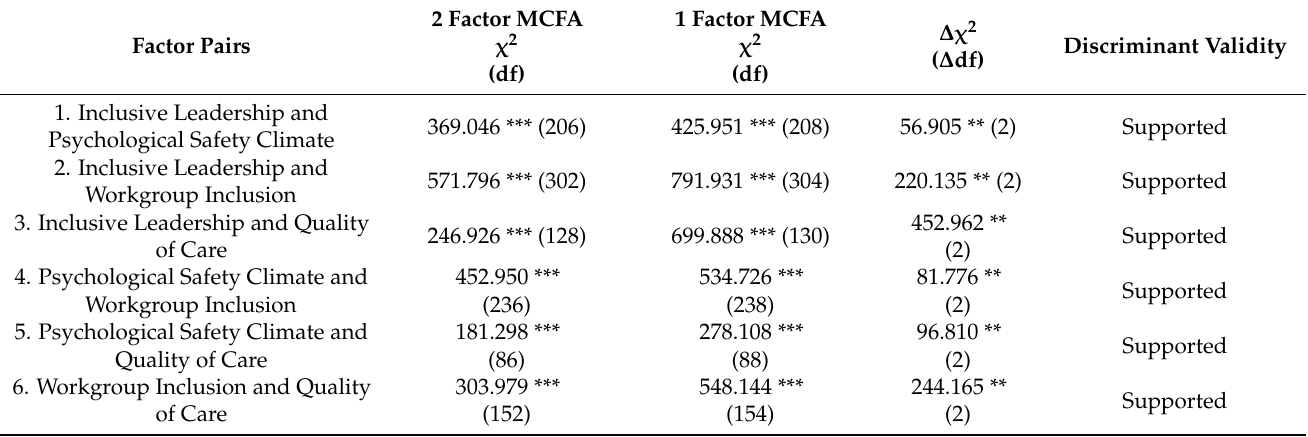
Table 2. Discriminant validity.